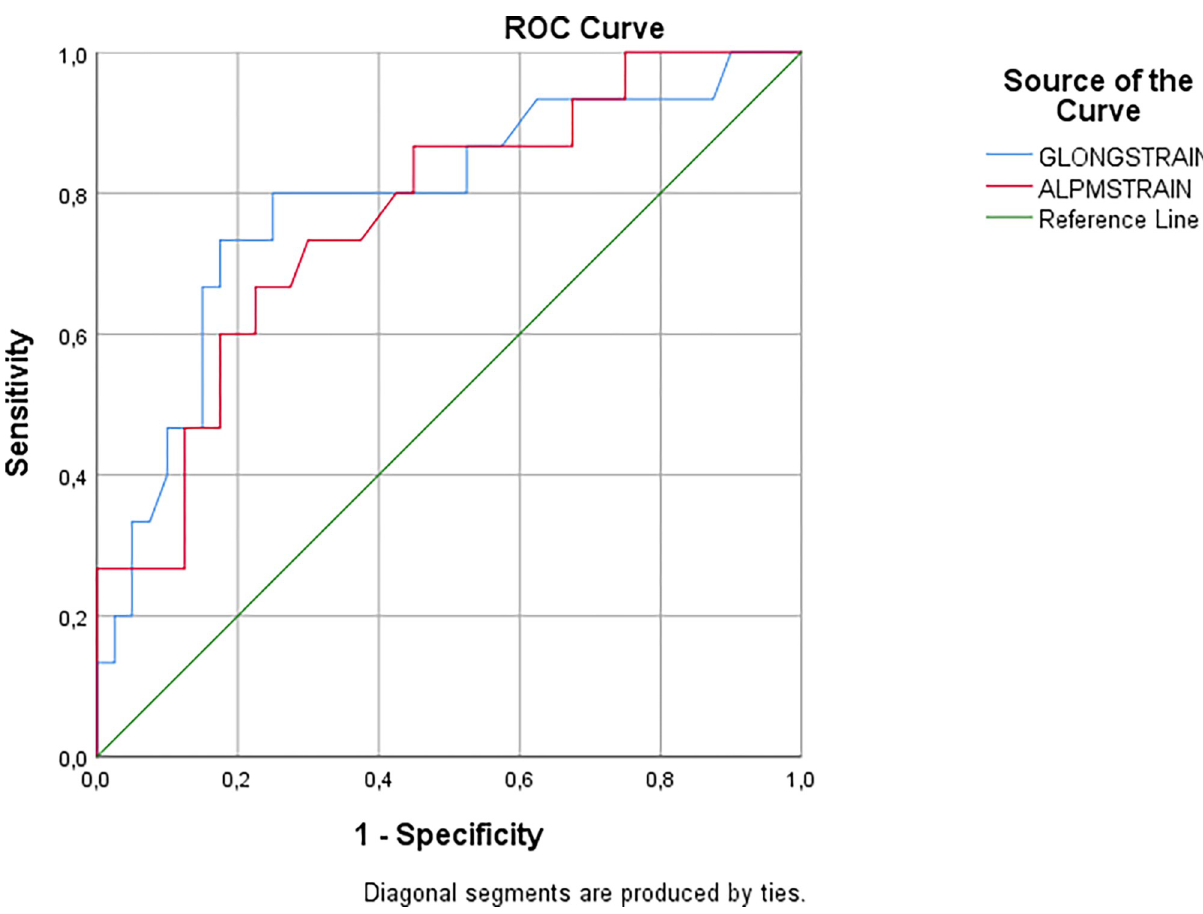
Fig 4. ROC curve analysis of global longitudinal strain and ALPM free strain for prediction of high SCD risk score.